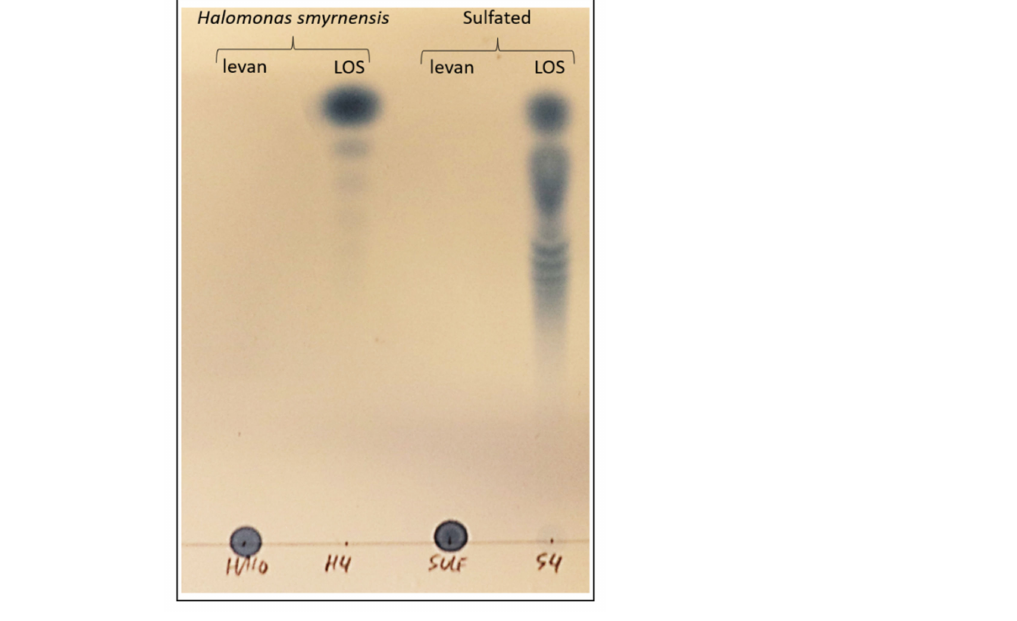
Figure 3. Sulfated levan can be hydrolyzed by a microbial endo-levanase. Similar to Halomonas smyr- nensis levan, the sulfated levan variant was hydrolyzed by Bacteroides thetaiotaomicron endo-levanase. LOS fractions were purified and analyzed with